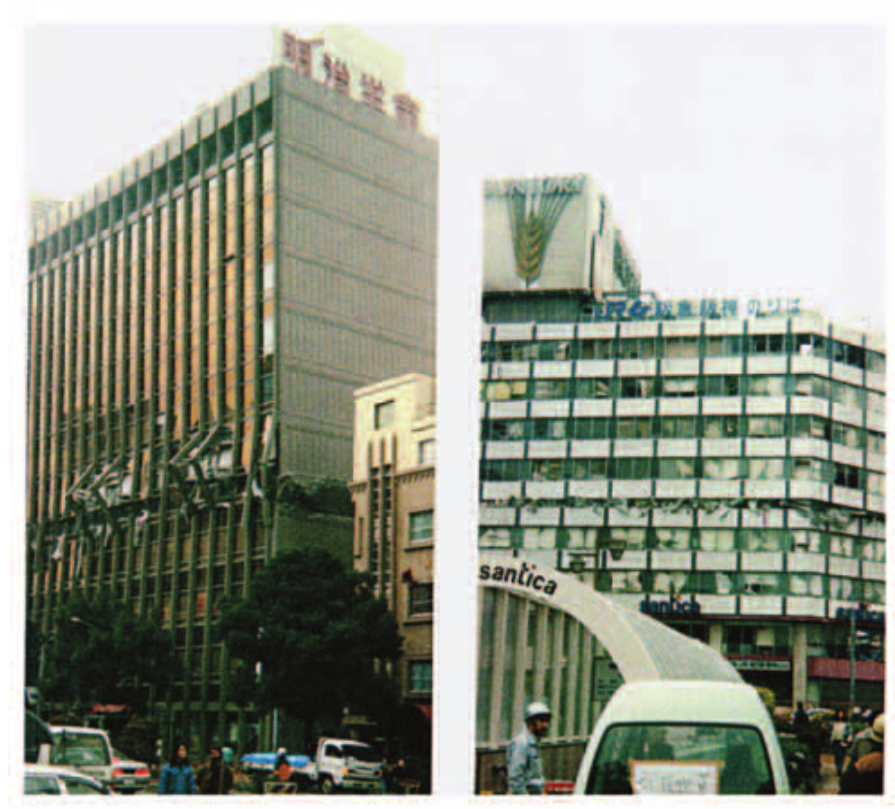
Fig. 1. Story collapse of reinforced concrete frames in Kobe